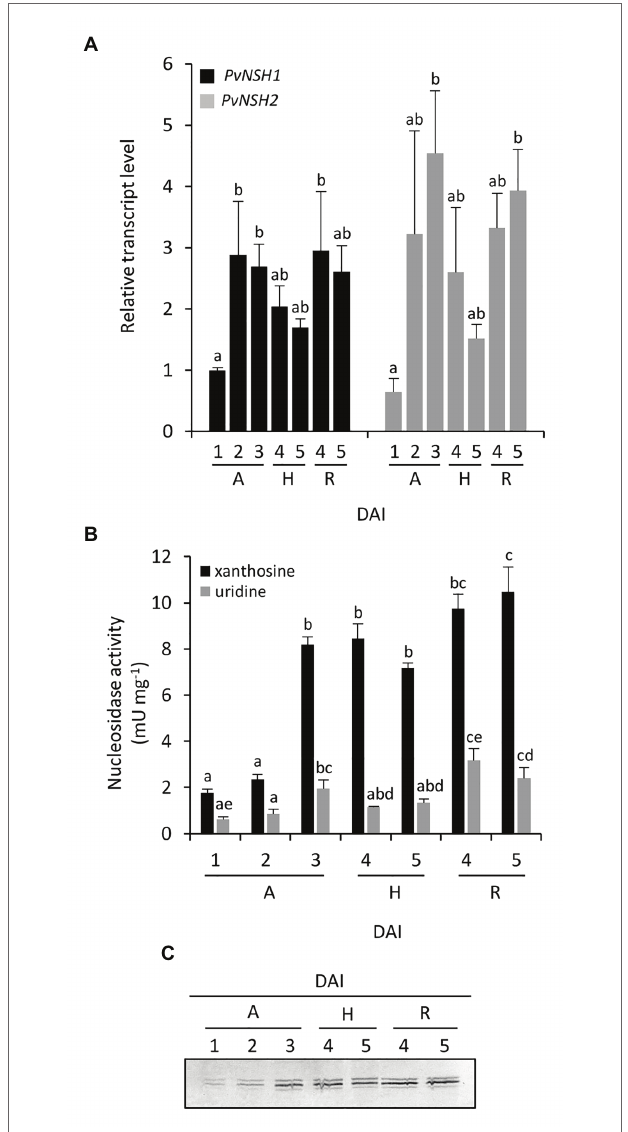
FIGURE 4 | Nucleosidase regulation during germinative and early postgerminative development of embryonic axes, radicles and hypocotyls. (A) Evolution of PvNSH1 and PvNSH2 mRNA levels, (B) nucleosidase activity, and (C) immunodetection of nucleosidase during germination and early postgerminative development. Real-time qRT-PCR results were normalized with the geometric mean of actin-2 and ubiquitin genes and expressed relative to the expression of PvNSH1 in axes at 1 DAI, which was considered the value 1. Nucleosidase activity was assayed as described in the section “Materials and Methods” using xanthosine or uridine as substrate. Nucleosidase immunodetection was performed with polyclonal